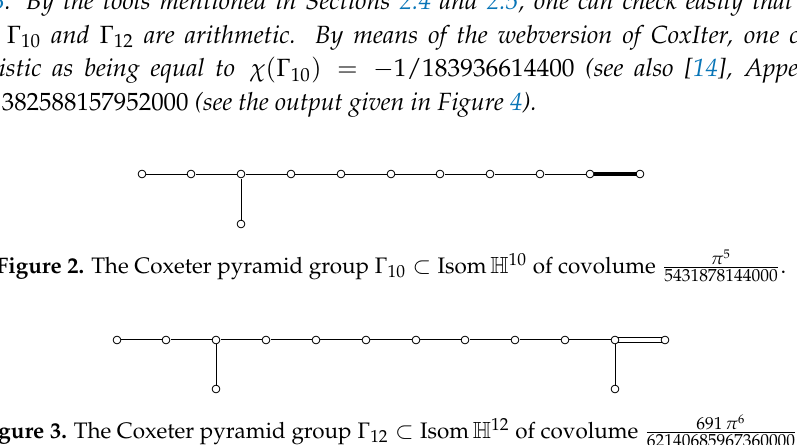
. 62140685967360000